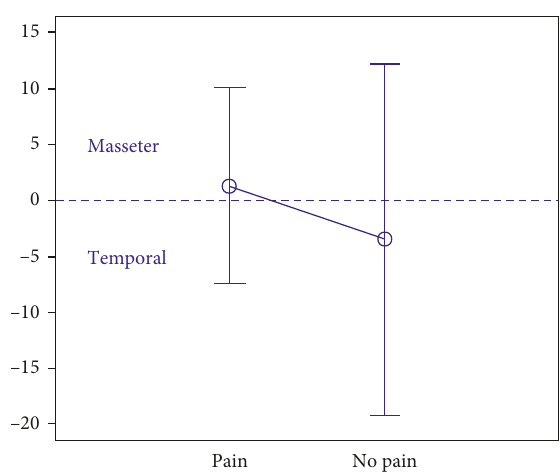
Figure 1: Activity index at rest in group of healthy individuals.